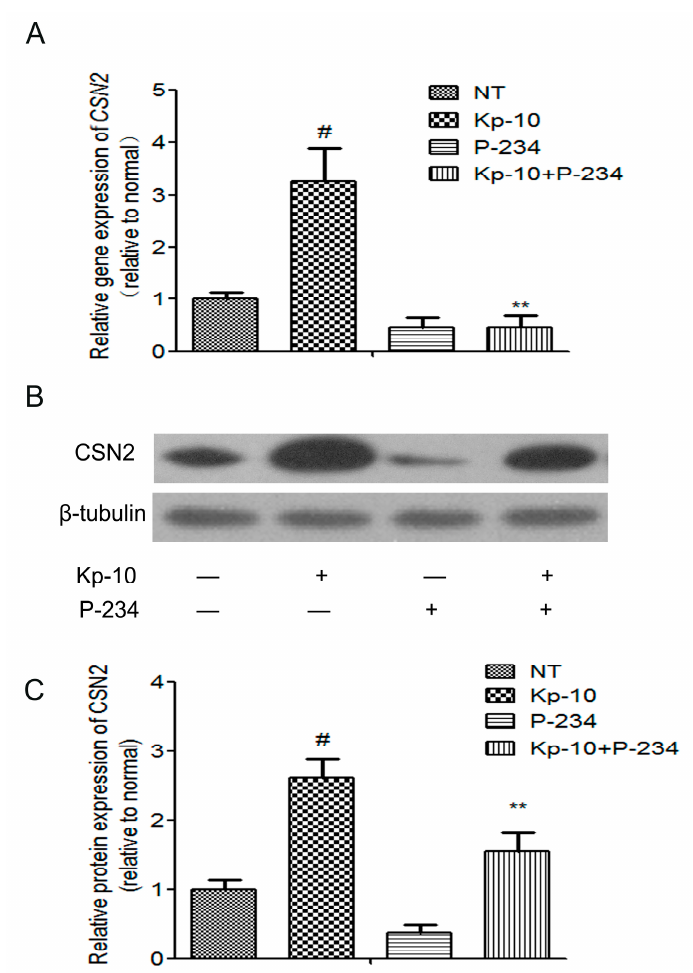
Figure 4. Peptide-234 (P-234) inhibited the Kp-10-induced mRNA and protein expression of CSN2 in bMECs. The cells were pre-treated for 1 h with P-234 (1 µ M) and then incubated for 12 h with Kp-10 (100 nM). The gene ( A ) and protein ( B , C ) expression of CSN2 was examined by quantitative real-time PCR and Western blot. The relative mRNA level was normalized to β -tubulin mRNA, and the relative protein levels were quantified by scanning densitometry and normalized to β -tubulin. The data are presented as the means ± S.D. ( n = 3; # p < 0.01 vs. NT; ** p < 0.01 vs. Kp-10 treatment).